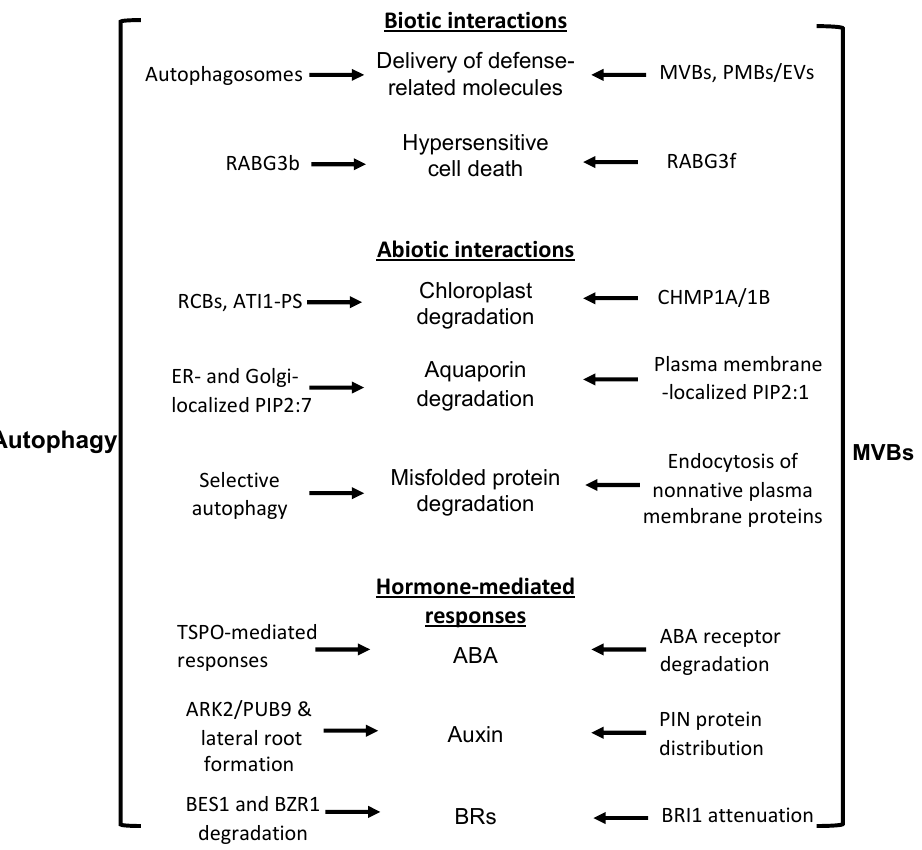
Figure 2. Coordination and crosstalk between the autophagosome and MVB pathways in plant biotic and abiotic interactions and in plant hormone-regulated stress responses.